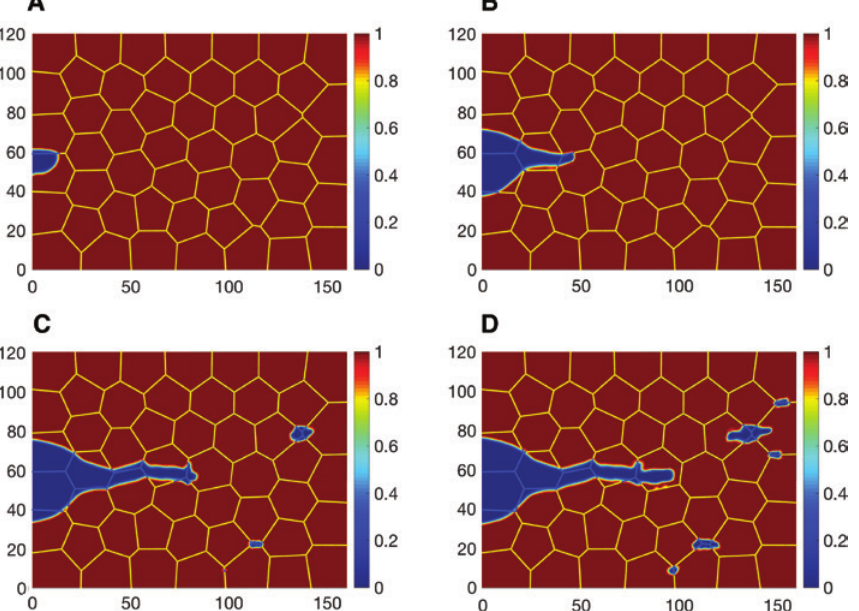
Figure 9: Crack propagation for polycrystalline structure containing 50 grains. The phase field is plotted corresponding to several loading steps. (A) U = 1.10 μ m (t = 305 min); (B) U = 1.31 μ m (t = 410 min); (C) U = 1.40 μ m (t = 455 min); (E) U = 1.42 μ m (t = 470